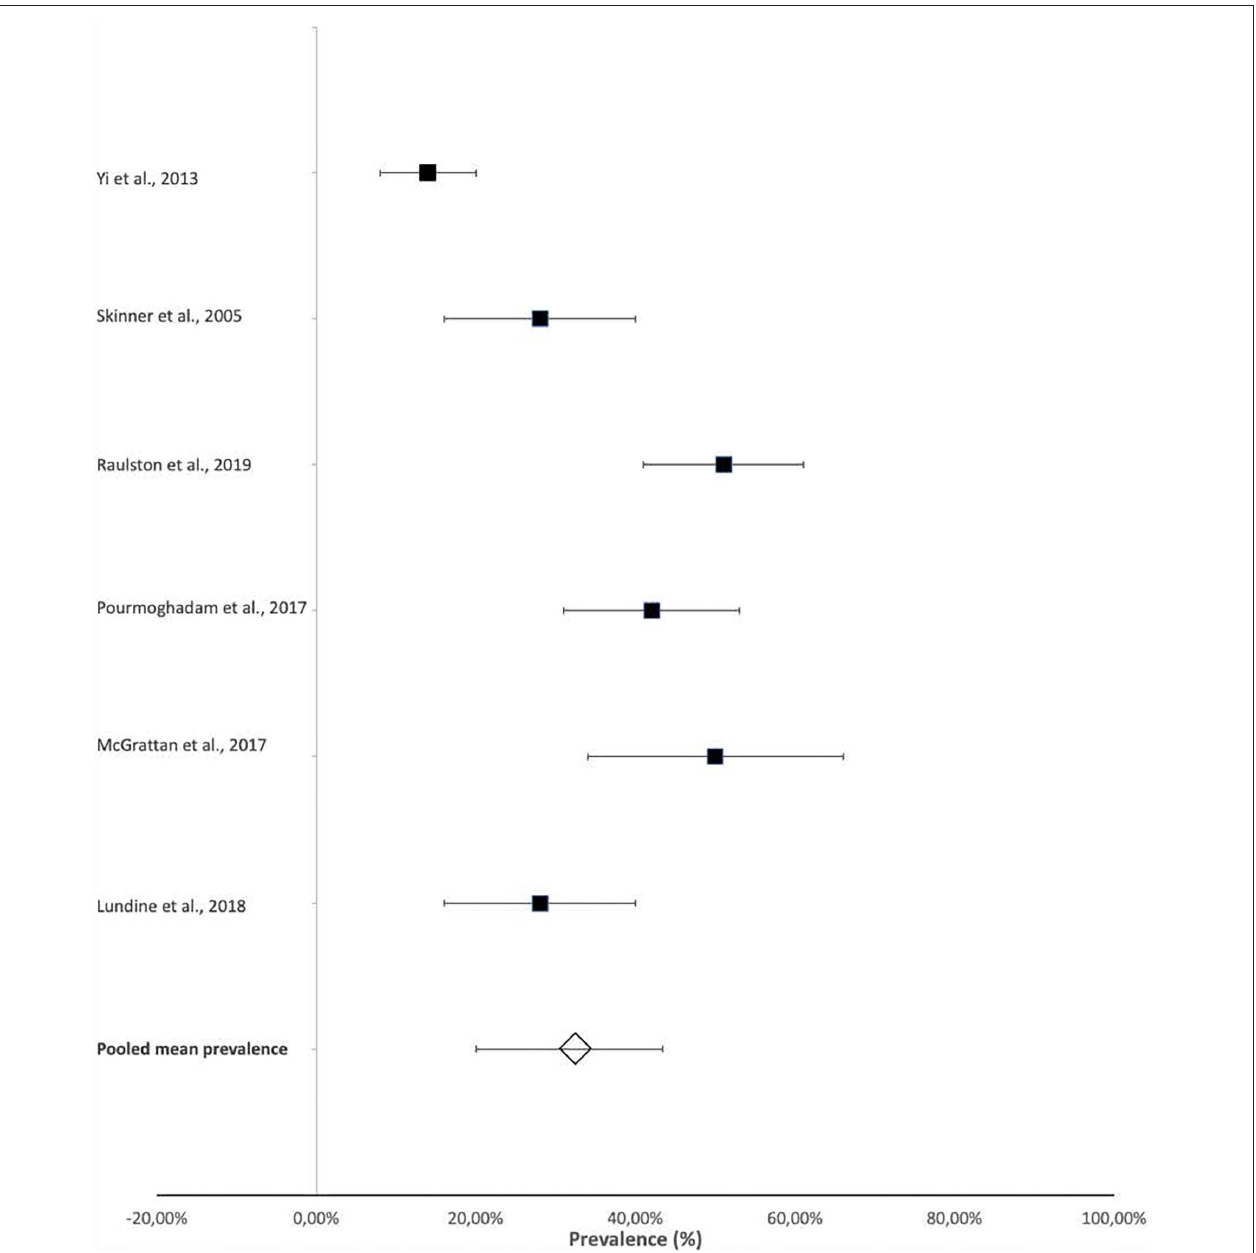
FIGURE 3 | Prevalence of aspiration in infants and children with CHD. *Aspiration was documented on videofluoroscopic swallow studies or fiberoptic endoscopic evaluation of